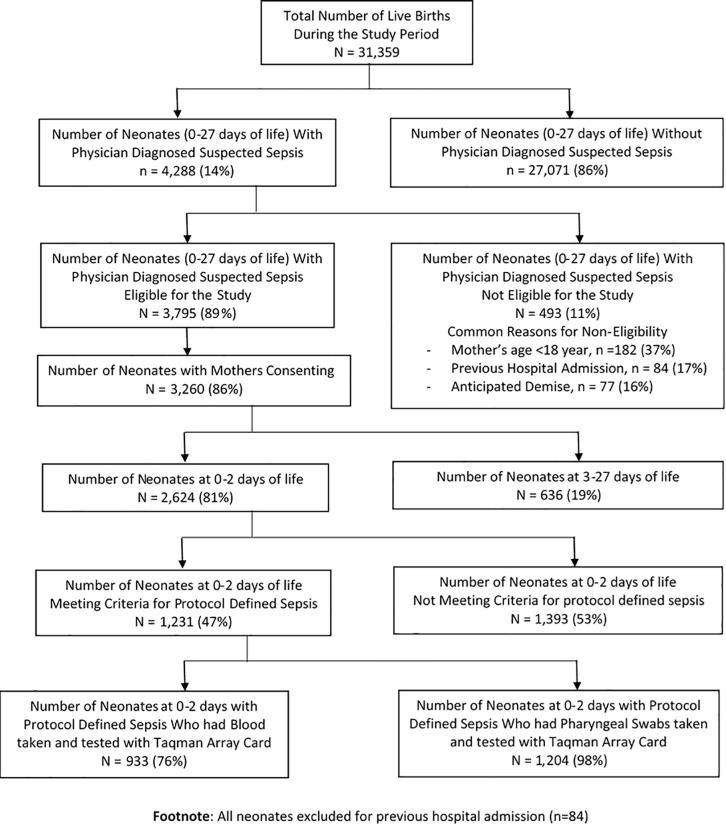
Flow chart of enrolled neonates with physician diagnosed suspected and protocol defined sepsis.